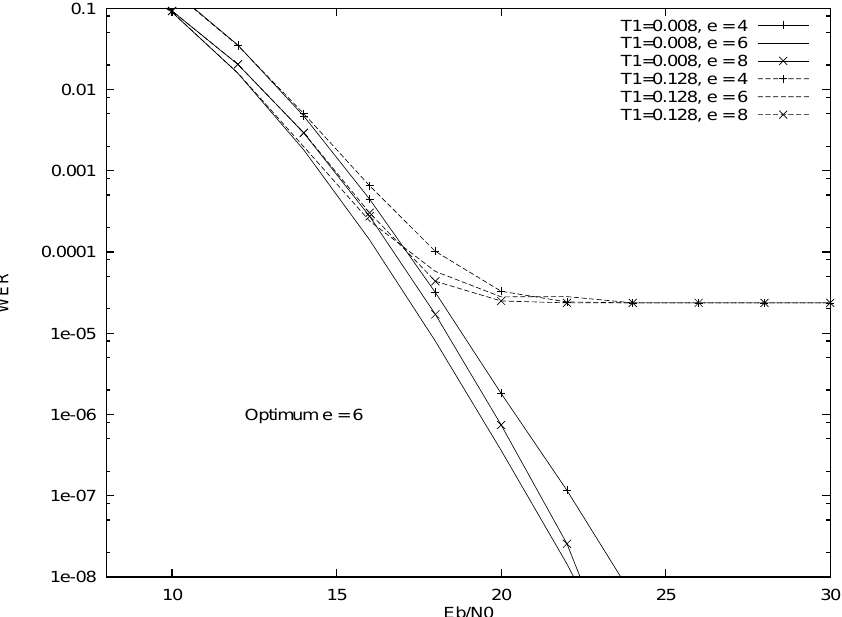
Figure 7. WER vs. E b / N 0 for truncation only with ordering and comparing a